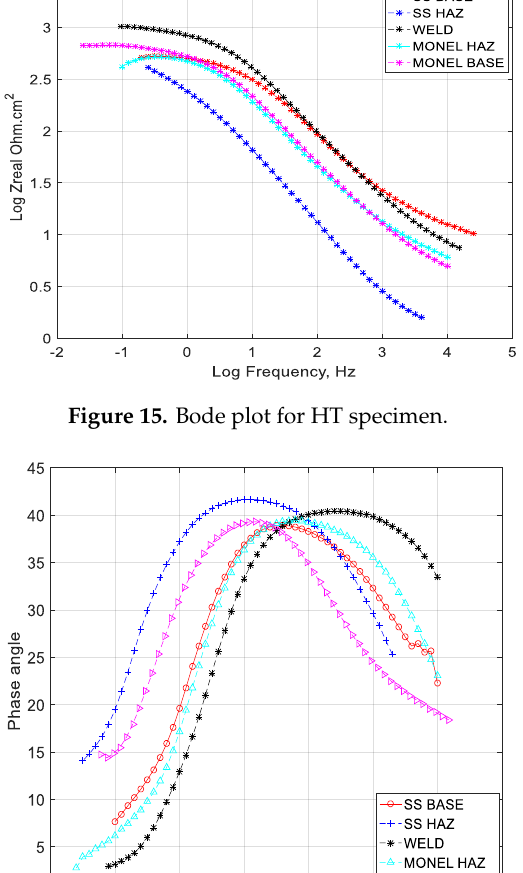
Figure 14. Bode plot for CT specimen.